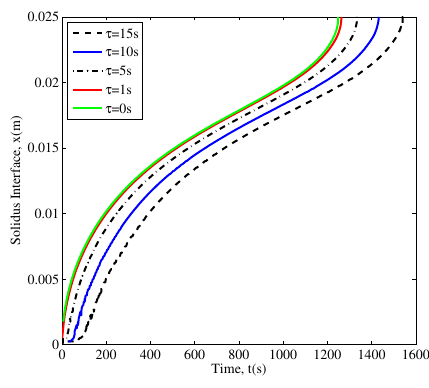
Figure 5. Solidus interface position for the value of τ = 15 s , τ = 10 s , τ = 5 s , τ = 1 s , τ = 0 s .